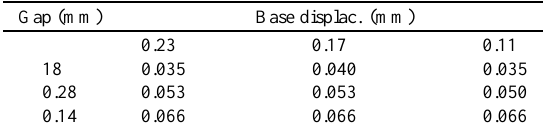
Table 3 Effect of gap and base displacement on damping ratio (magnets in base